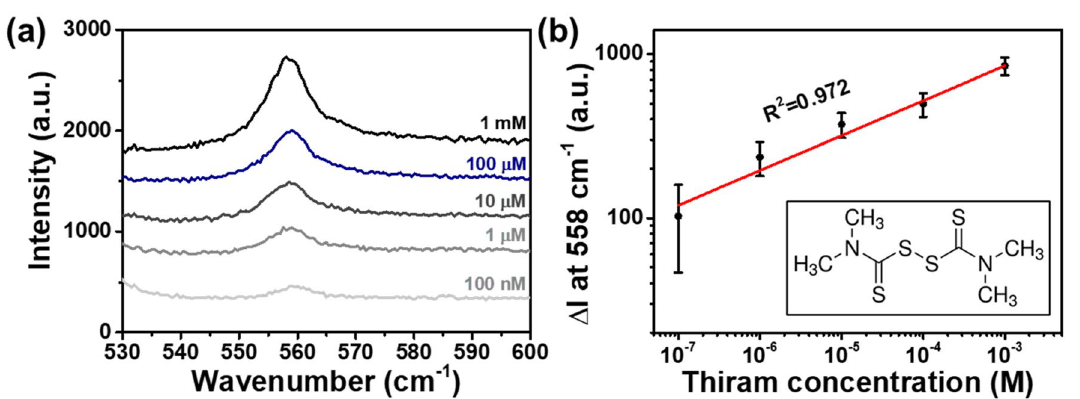
Figure 6. SERS enhancement of the AuNP_35nm@BDMT@AuIF for thiram. ( a ) SERS spectra of the AuNP_35nm@BDMT@AuIF sensor at thiram concentrations of 10 − 5 to 10 − 7 M. ( b ) Raman intensity at 558 cm − 1 as a function of the logarithmic concentration of thiram. The inset indicates the molecular structure of